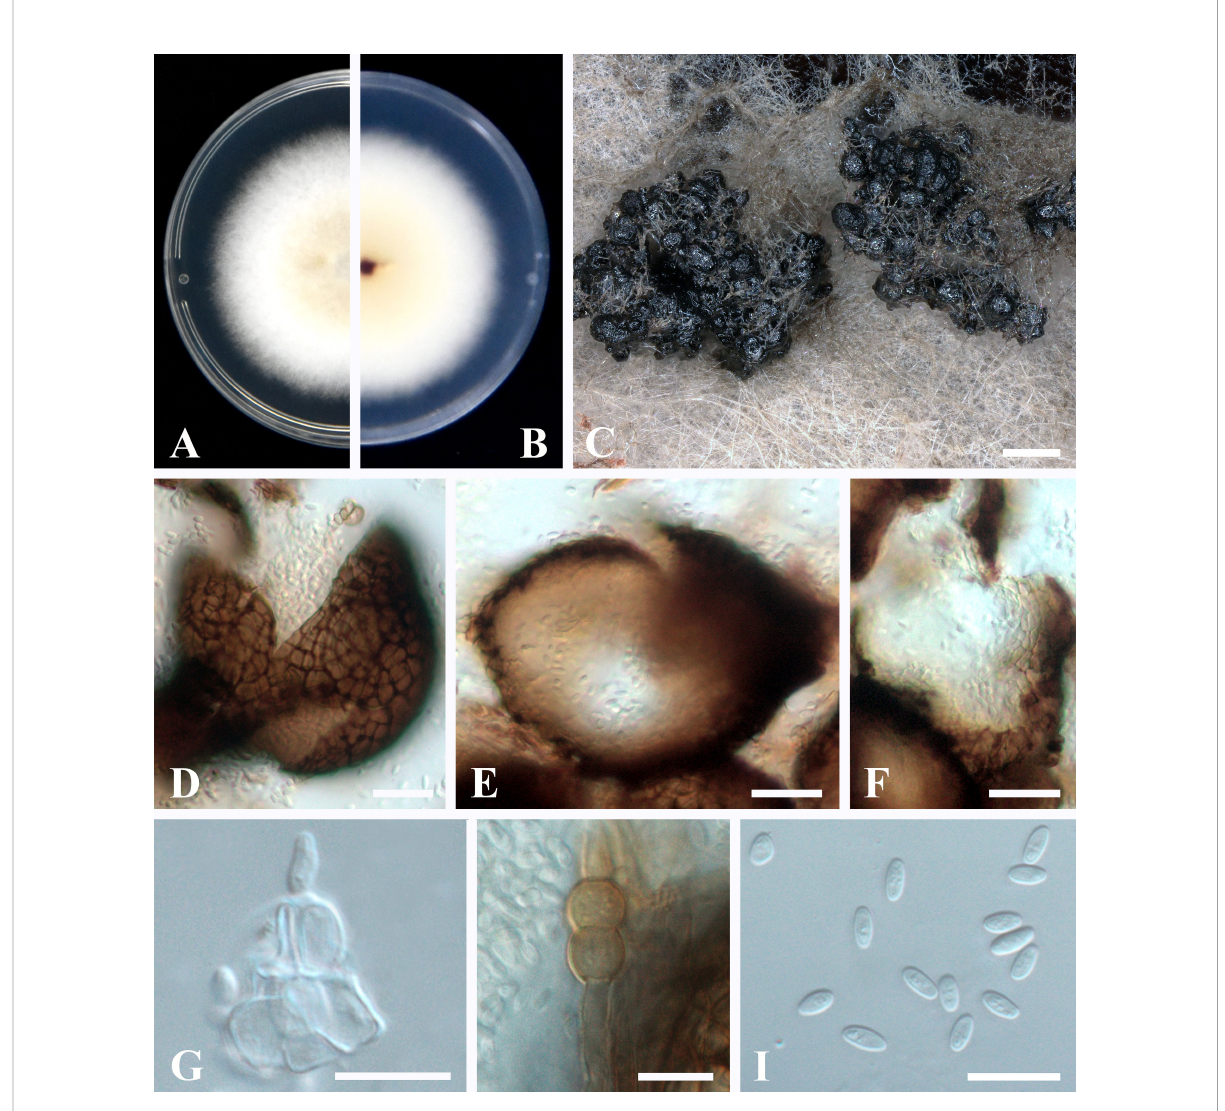
FIGURE 4 Epicoccum latusicollum (HGUP191049). (A, B) . Colony on PDA (front and reverse). (C) Pycnidia forming on PDA. (D) Pycnidia. (E) Section of pycnidium. (F) Section of pycnidial wall. (G) Conidiogenous cells. (H) Chlamydospores. (I) Conidia. Scale bars: C = 200 m m; D – F = 20 m m; G – I = 10 m